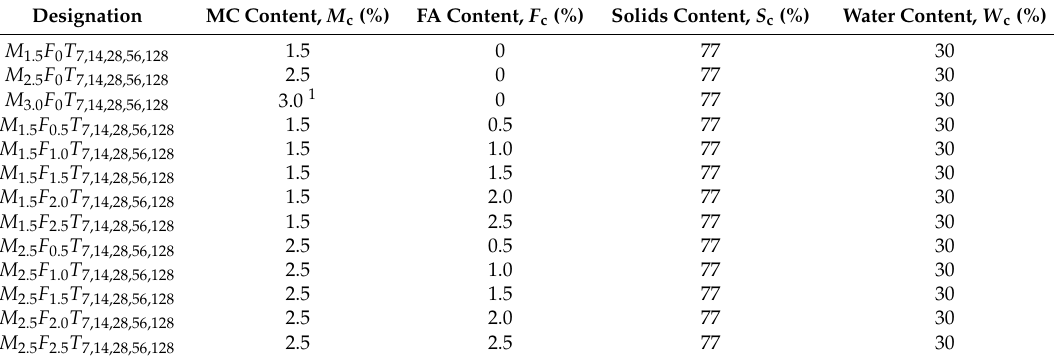
Table 5. Mix designs and their